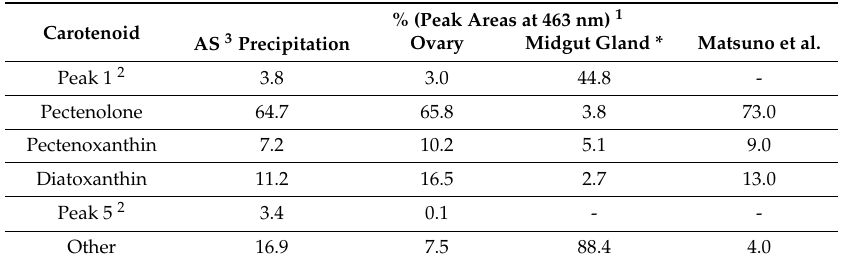
Table 1. Carotenoid compositions of the organs of scallop M. yessoensis.